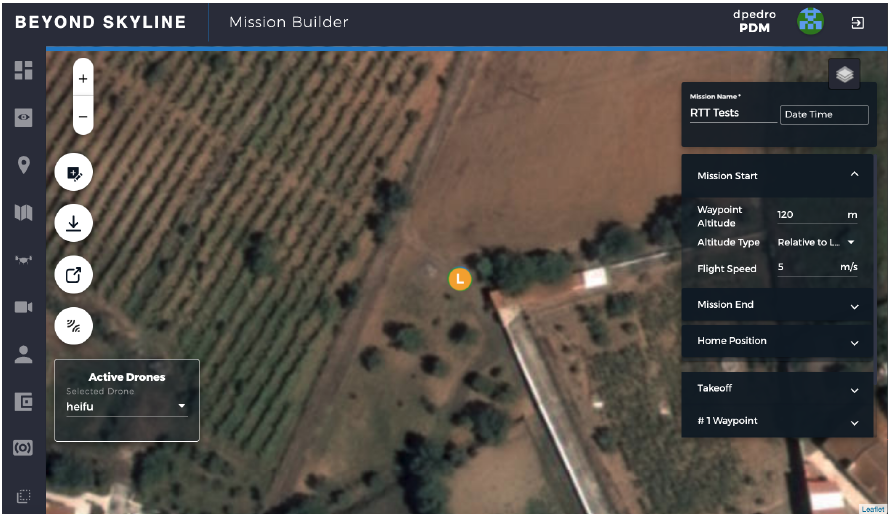
Figure 9. Round Trip Time (RTT) tests missions planning on the Beyond Skyline